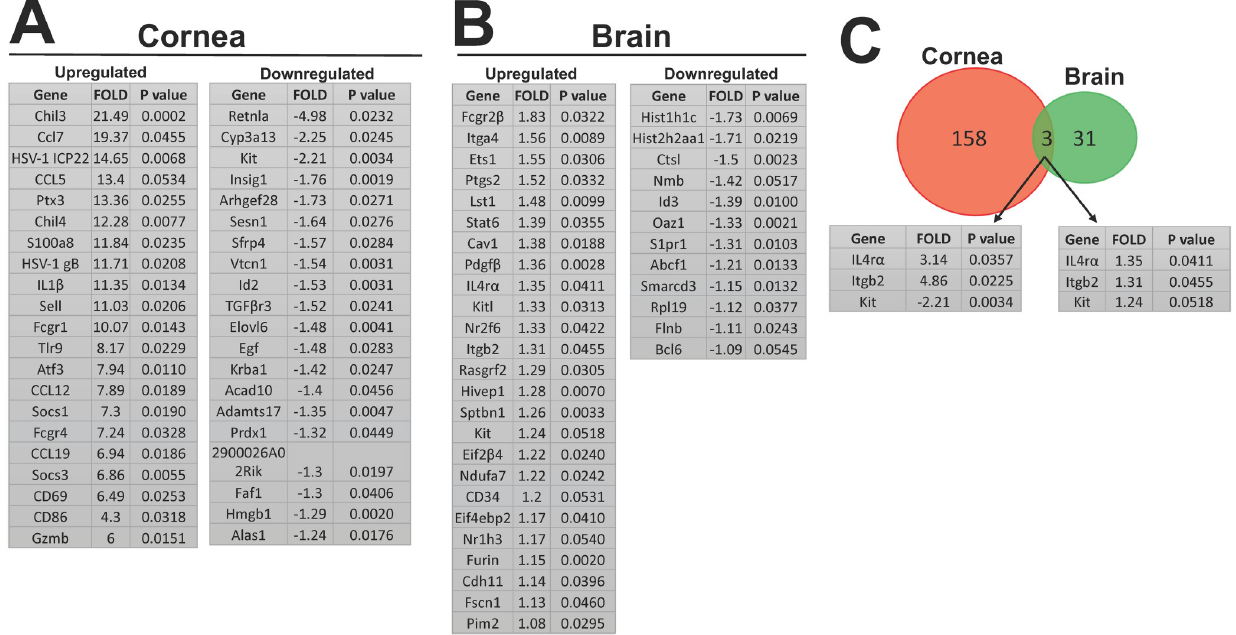
Fig 8. Nanostring gene expression analysis of infected cornea and brain on day 4 PI. WT and M1 -/- mice were ocularly infected with 2 X 10 5 pfu/eye of McKrae virus without corneal scarification. Corneas and brain were collected on day 4 PI and total RNA from pooled corneas per mouse and individual brain were isolated. Total RNA concentration in each well remained at 20 ng/ μ l. Expression of the 764 gene myeloid immune panel was analyzed as described in Materials and methods. Differentially expressed genes were identified for each group by normalizing samples to housekeeping genes and infected WT mice. A) Upregulated and downregulated genes in cornea after infection. Out of 158 genes totally expressed, the first 22 upregulated genes and the first 20 downregulated genes in infected corneas of M1 -/- mice are shown: B) Upregulated and downregulated genes in brain after infection. Out of 31 genes totally expressed, 19 were upregulated, and 12 were downregulated in brain of M1 -/- mice when compared to WT infected mice; and C) Venn Diagram showing common genes expressed in corneas and brain of infected mice. IL4r α , Itgb2 and Kit were commonly expressed in corneas and brain of infected mice with different p-values. N = 3 mice corneas or